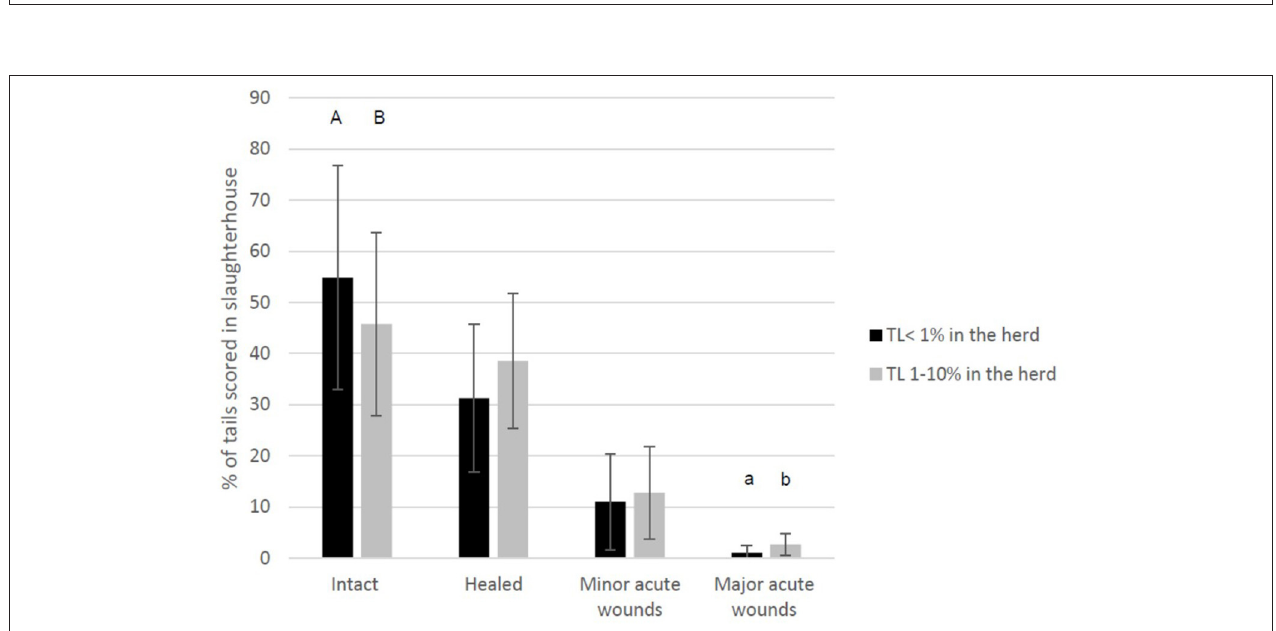
FIGURE 3 | The average percentage of undocked tails of finishing pigs per herd ( n = 84) scored at the slaughterhouse in four categories (intact, healed, with minor acute wounds, and with major acute wounds) and divided according to the evaluation recorded in the same herds during the herd health visit (TL, Tail Lesion < 1%: no or single cases of tail-bitten pigs during the herd health visit, TL 1–10% of pigs with bitten tail). Within tail score comparisons, different letters represent statistical significance or tendency: ab p < 0.01, AB p < 0.1.